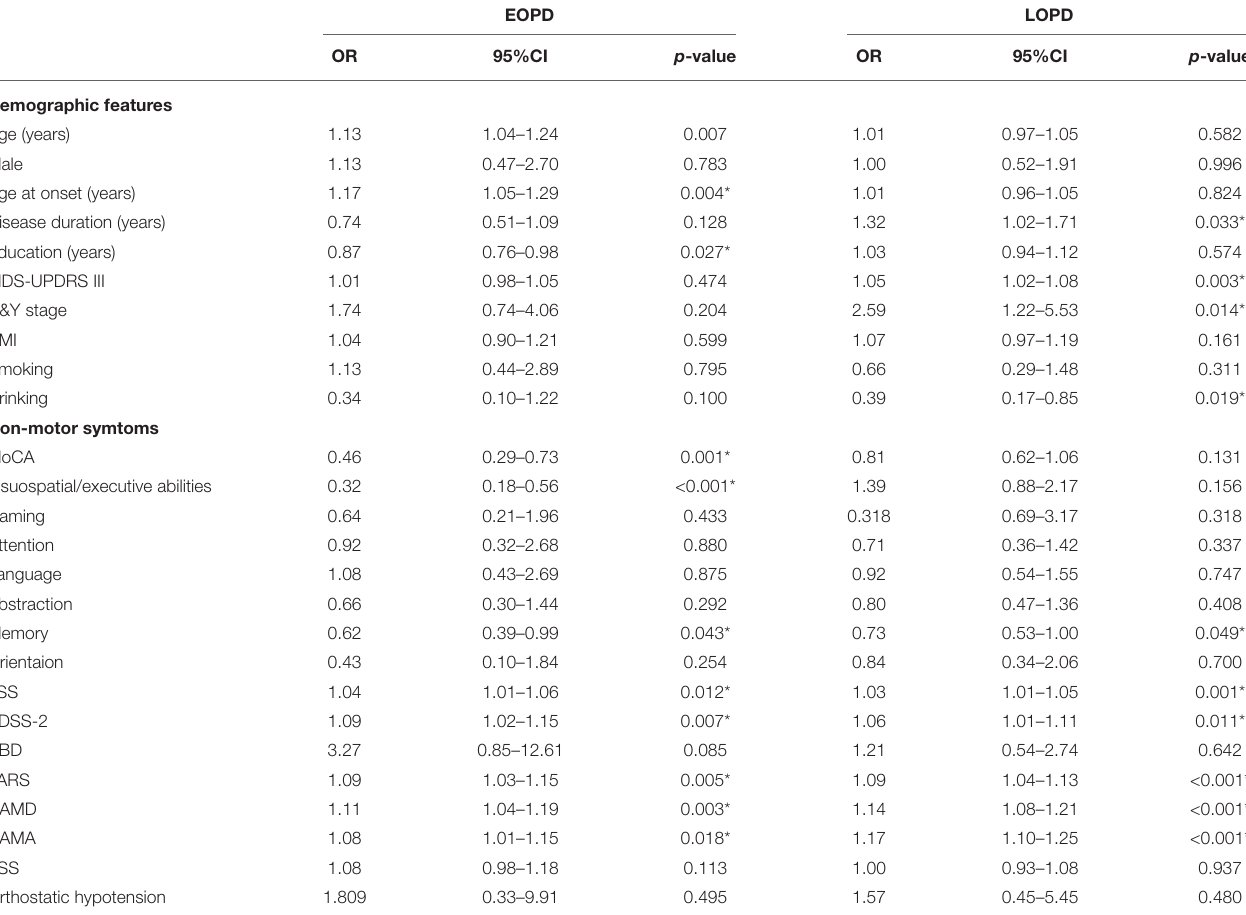
TABLE 2 | Factors associated with SCCs in the patients with EOPD and LOPD in univariate logistic regressions. EOPD LOPD OR 95%CI p -value OR 95%CI p -value